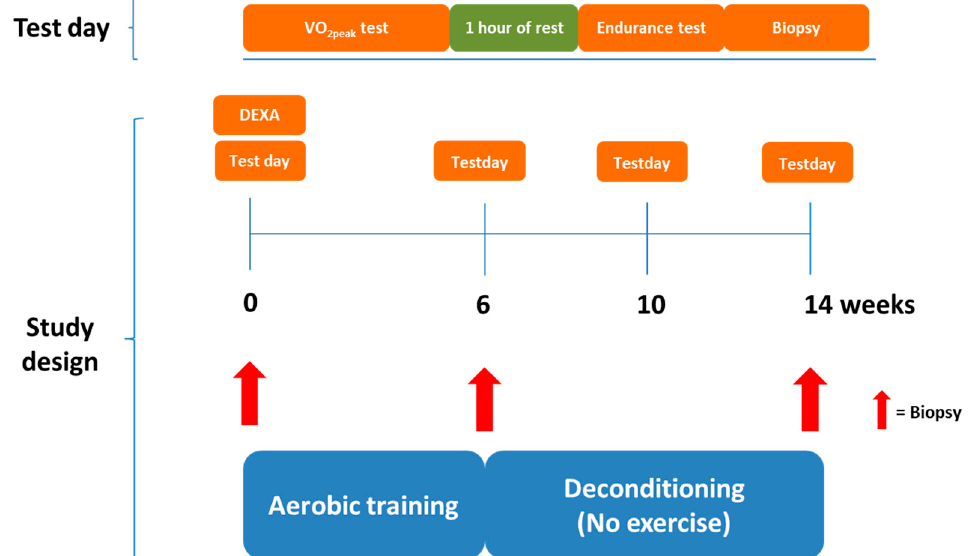
Figure 1. Study design overview. Twenty-one participants completed a 6 week aerobic